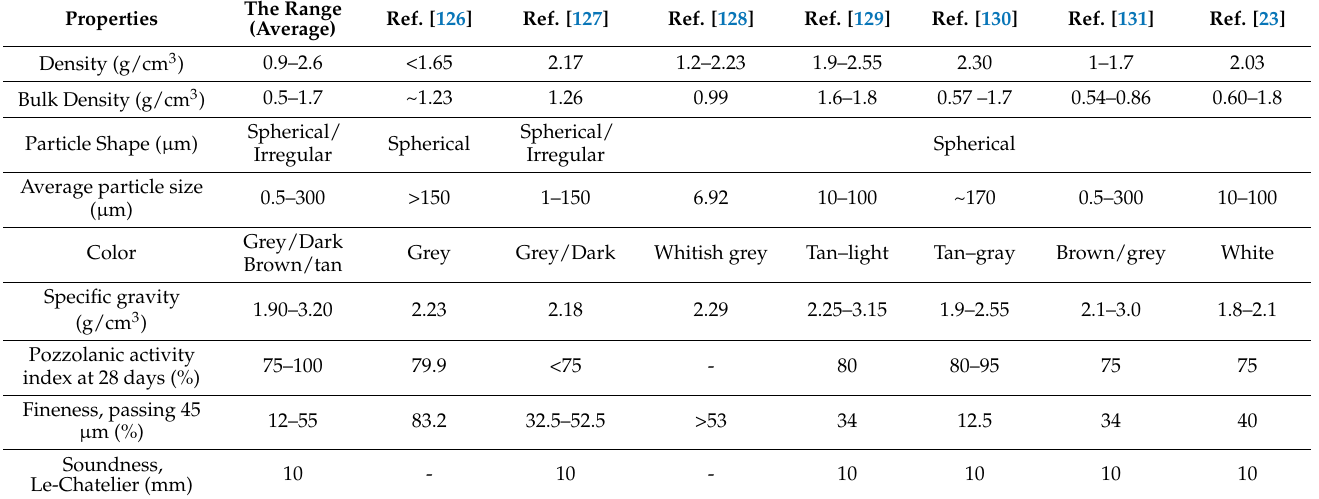
Table 6. Physical properties of